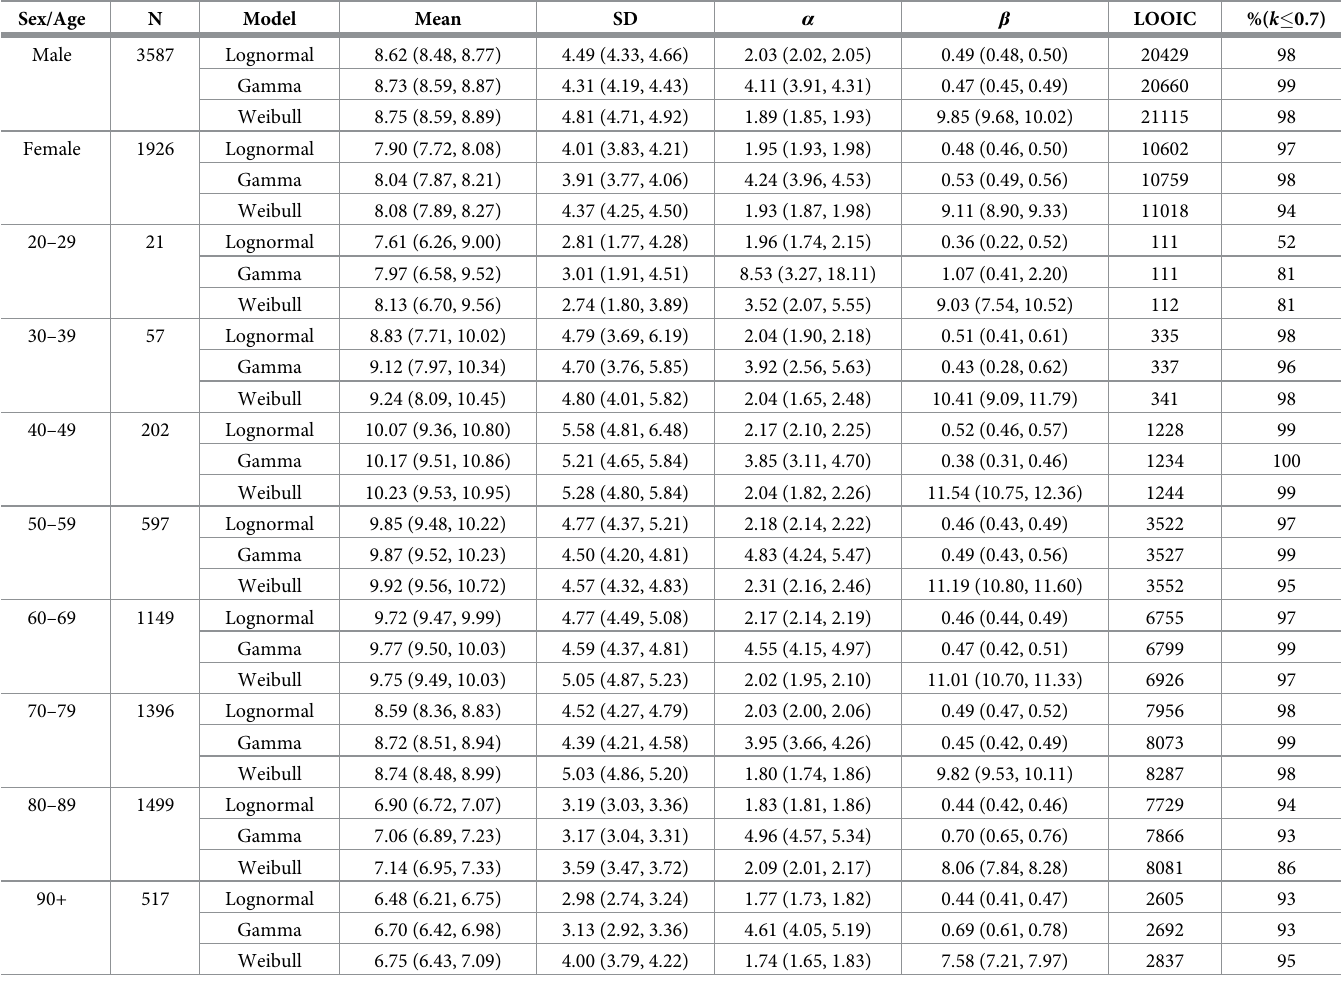
Table 5. Results for the time from infection to hospitalisation by sex and